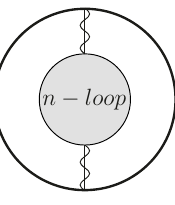
Figure 8 . The graphical representation of the contribution to correction of the gluon and scalar